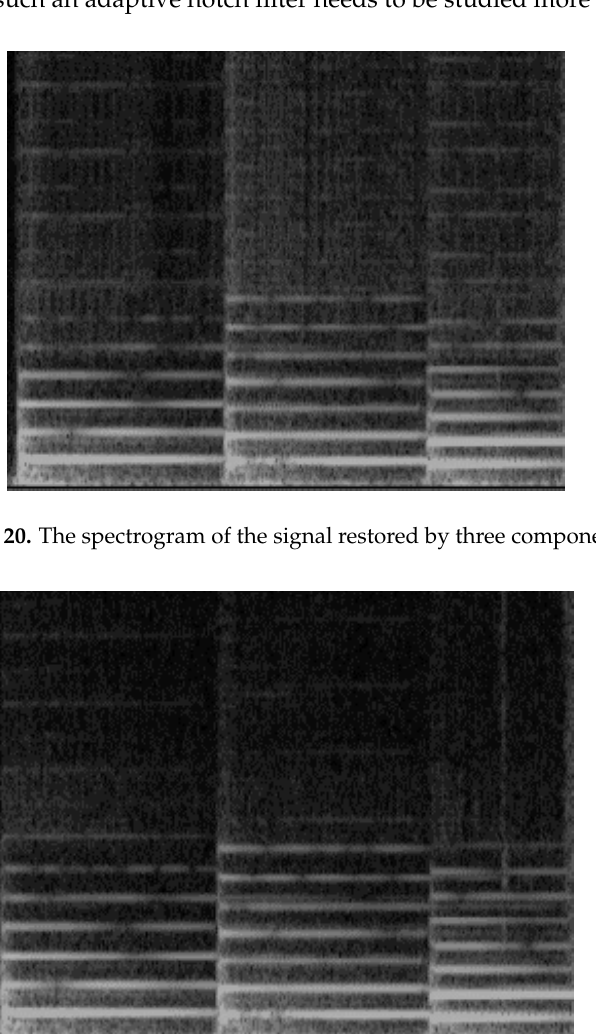
Figure 22. The spectrogram of the signal restored by five components. 7. Conclusions The framework of proposed multi-frame PCA-based audio coding method has several differences compared to other codecs; therefore, there are lots of barriers to the design of an optimal algorithm. This paper proposed several ways to remove those barriers. For mono signal, the design of PCA-based coding method in this paper, including multi-frame signal processing, matrix design, and quantization design can hold it efficiently. As to stereo signal, PCA has high associativity with parametric stereo, which makes PCA-based parametric stereo certainly feasible and significant. Experimental results show satisfactory performance of the multi-frame PCA-based stereo audio coding method compared with the traditional audio codec. In summary, research on the multi-frame PCA-based codec, both for mono and stereo, has certain significance and needs further improvement. This kind of stereo audio coding method has good performance in processing different kinds of audio signals, but further studies are still needed before it can be widely applied. Author Contributions: J.W. conceived the method and modified the paper, X.Z. performed the experiments and wrote the paper, X.X. and J.K. contributed suggestions, and J.W. supervised all aspects of the research. Funding: National Natural Science Foundation of China (No. 61571044) Acknowledgments: The authors would like to thank the reviewers for their helpful suggestions. The work in this paper is supported by the cooperation between BIT and Ericsson.